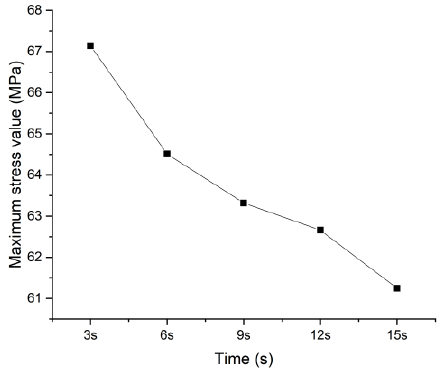
Figure 13. Maximum value of additional stress in the axial direction for different pump shutdown times. (Uniform tubing diameter of 3- 1/2″, inside pressure of 10 MPa).